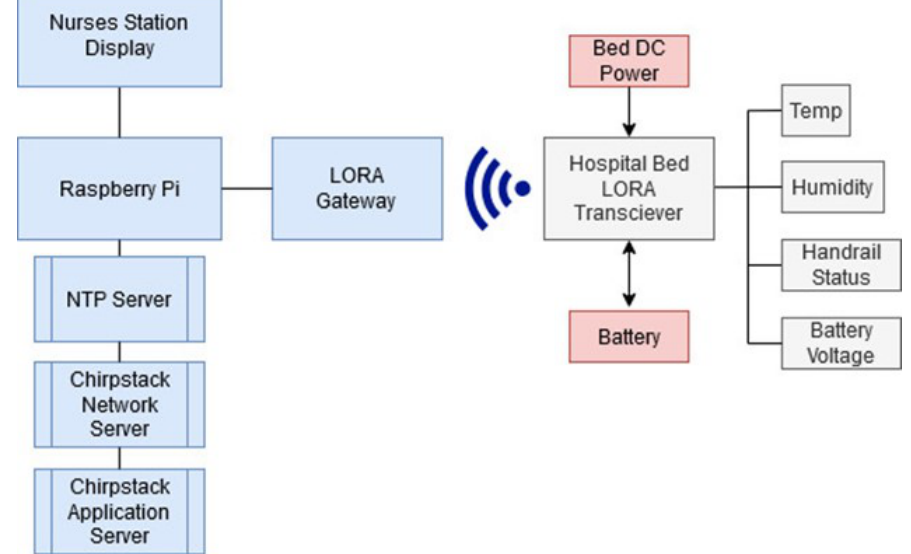
Figure 2. Overview of the system network topology and power inputs for remote